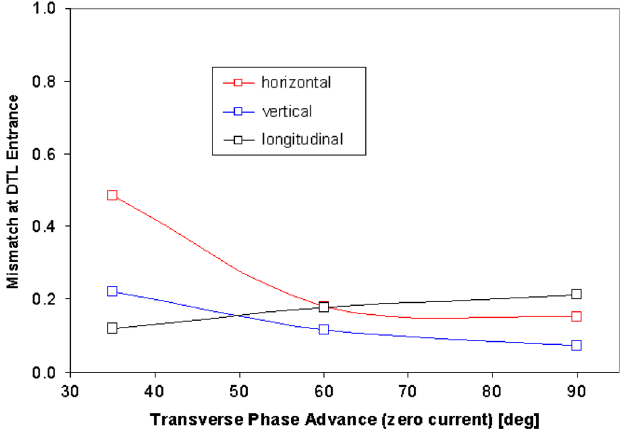
FIG. 22. (Color) Reduced mismatch between beam 95%-rms- Twiss parameters and the Twiss parameters for the rms-matched injection into the DTL as a function of the current phase advance (cid:4) o .